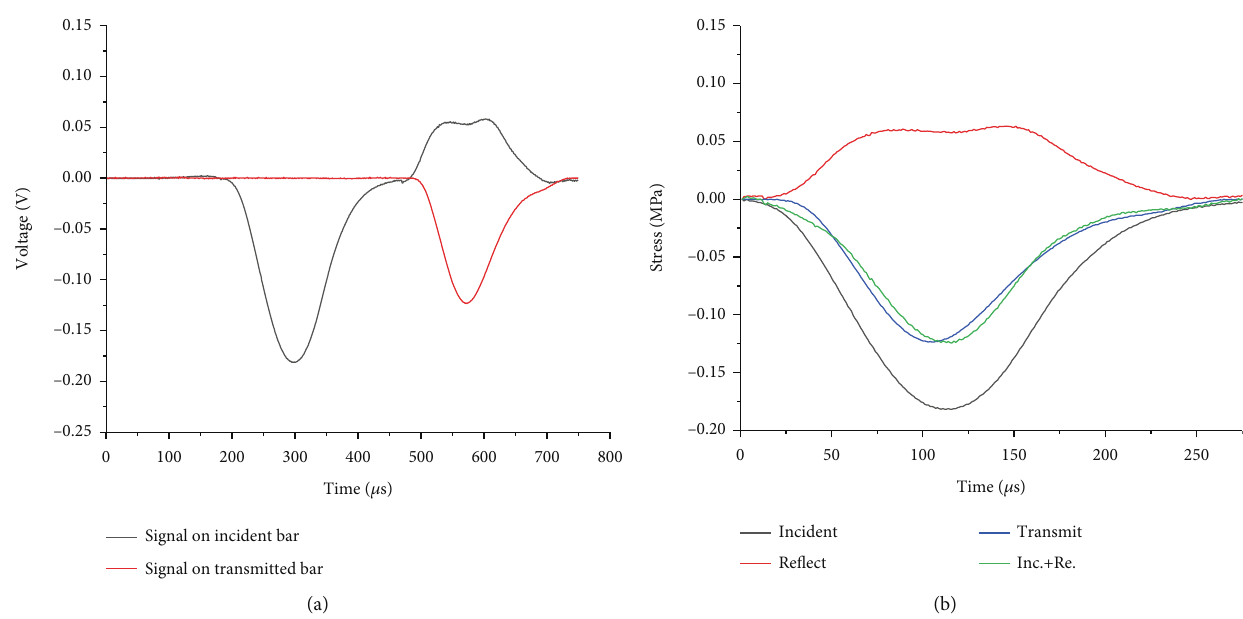
Figure 4: The voltage-time and stress wave-time curves. (a) The voltage time, (b) stress wave time.